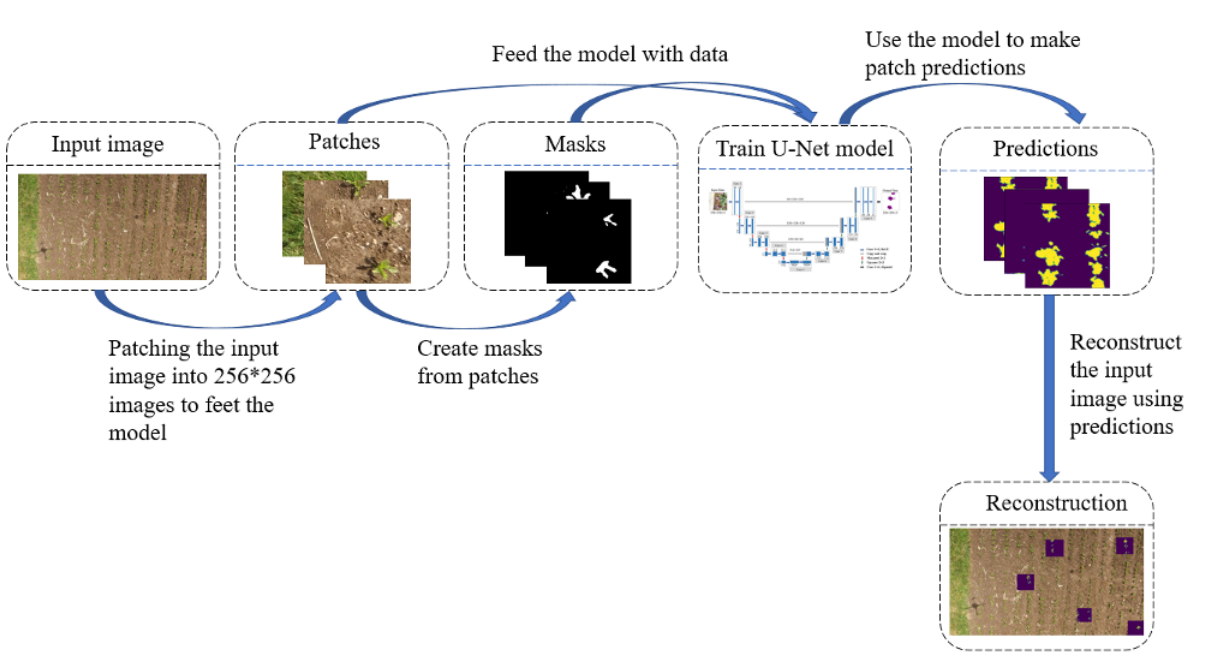
Fig. 8. Summary of the proposed